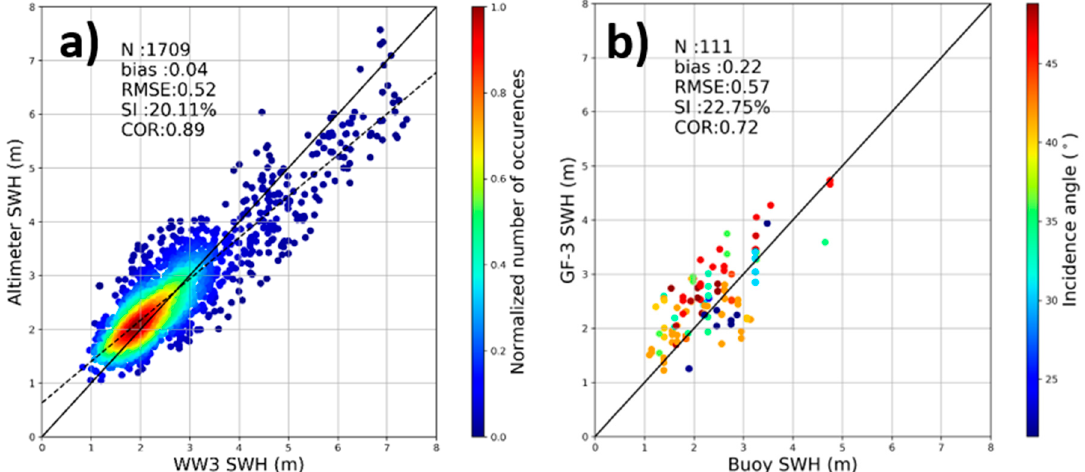
Figure 8. Scatter plots of SWH retrieved from GF-3 using the QPCWAVE_GF3 empirical model versus measurements derived from altimeters ( a ) and buoy measurements from NDBC ( b ).